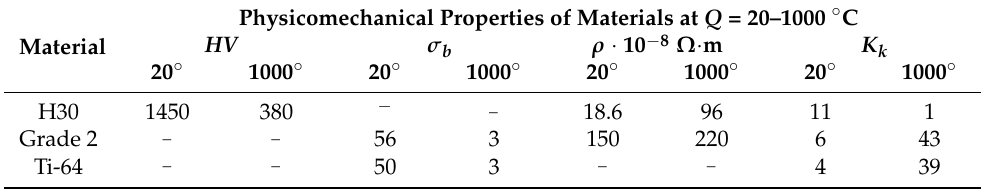
Table 2. Physicochemical properties of the cutting tool materials depending on the temperature.